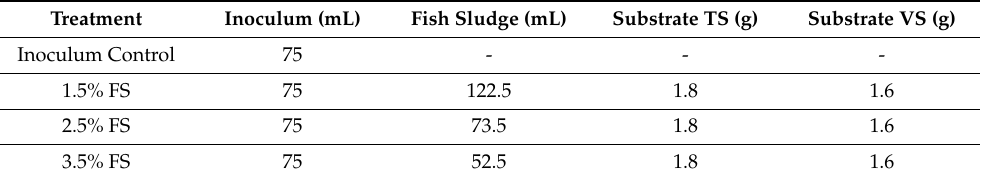
Table 2. Experimental design using a 2:1 inoculum-to-substrate ratio (by VS). All treatments were conducted in